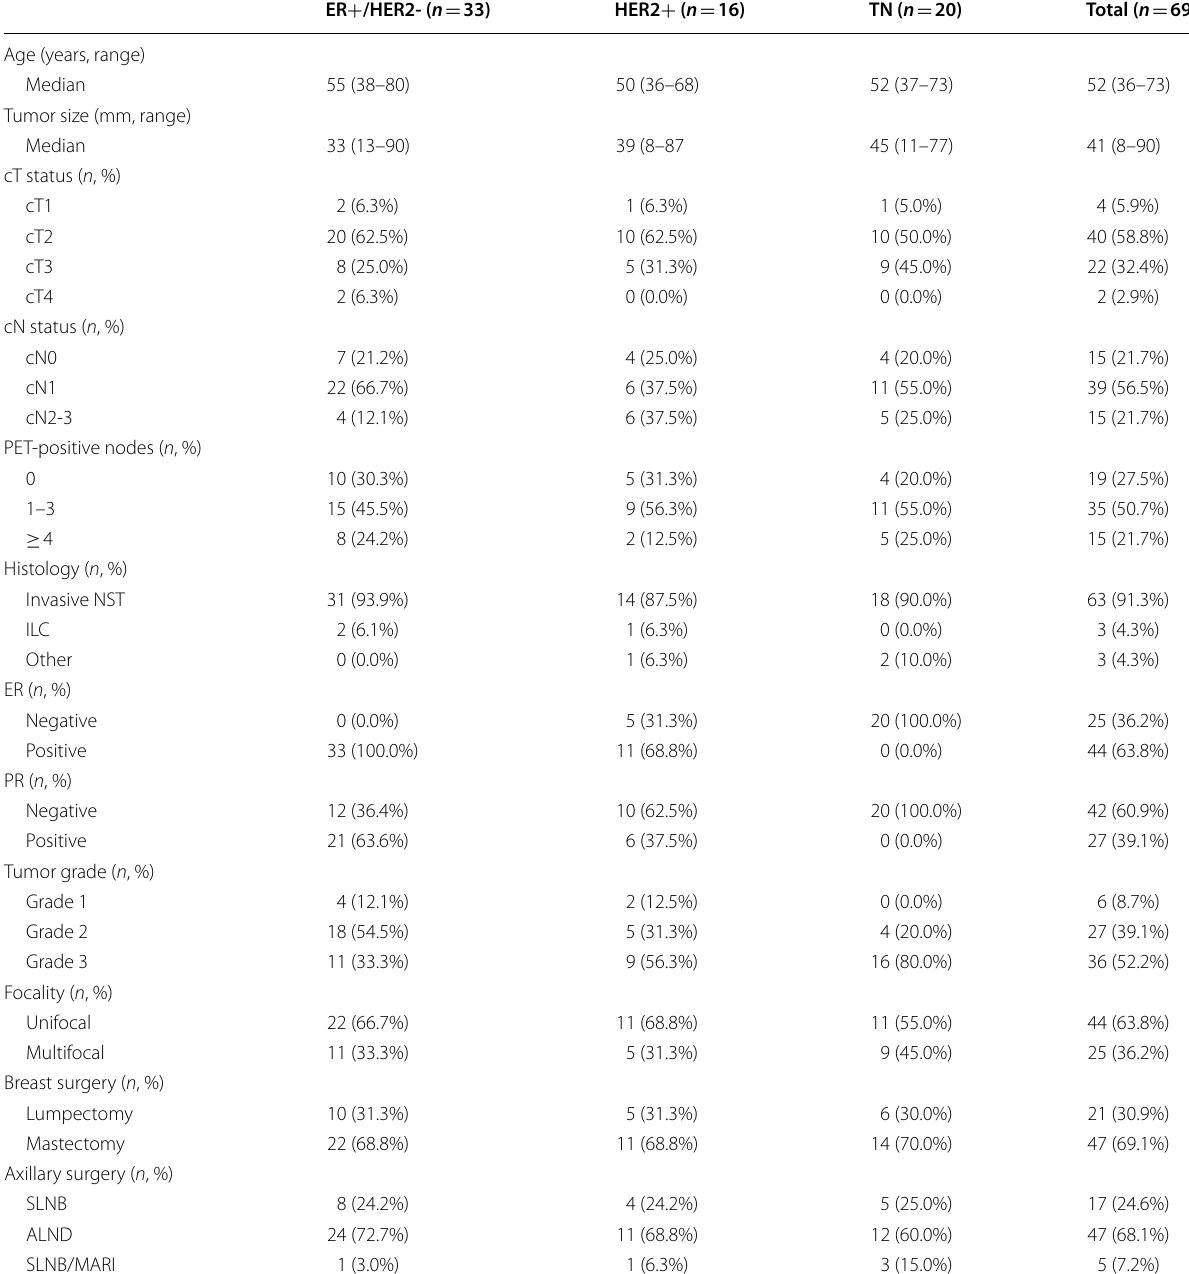
Table 1 Clinicopathologic and operative characteristics of all breast cancer patients and subdivided by breast cancer